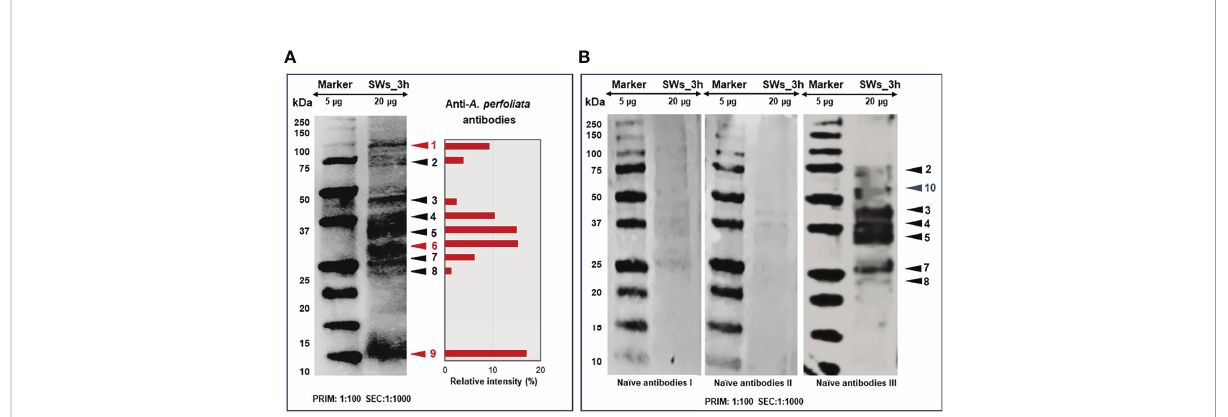
FIGURE 6 Representative 1DE immunoblots showing the protein bands reacting with the anti- A. perfoliata antibodies (A) and with antibodies from infection-naïve horse (B) . The E/S proteins excreted/secreted by SWs at three-hour time point were electroblotted to PVDF membrane fi rst probed with 1:100 diluted anti- A. perfoliata or infection-naïve antibodies and then with 1:1000 diluted rabbit anti-horse IgG (horseradish peroxidase conjugated) followed by DAB staining to visualize the reacting proteins. Arrow heads and numbers in red and black refer to the antigenic/immunogenic proteins speci fi c to A perfoliata and other potential parasites and/or micro-organisms, respectively. The cross-reacting protein antigens/immunogens were quantitated using the AlphaView software to obtain relative intensity values (%) for the indicated protein